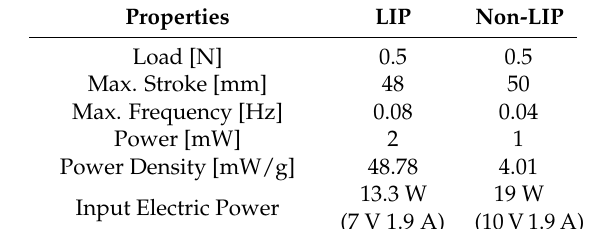
Table 4. Experimental Results of LIP and Non-LIP SMA coil spring actuators.